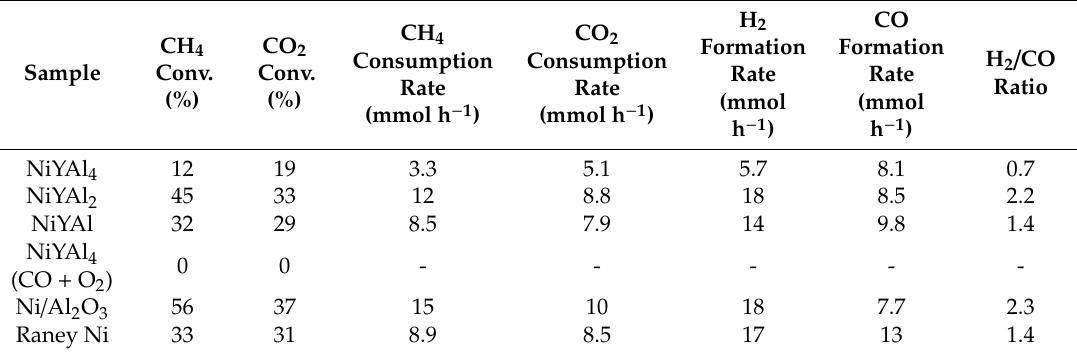
Table 1. Dry reforming of methane (DRM) parameters of various Ni catalysts including the nanoporous catalysts obtained from NiYAl, NiYAl 2 , and NiYAl 4 intermetallic precursors in this study as well as conventional Ni / Al 2 O 3 and Raney Ni catalysts. The NiYAl 4 sample showed no catalytic activity after the preferential oxidation (CO + O 2 ) without leaching.